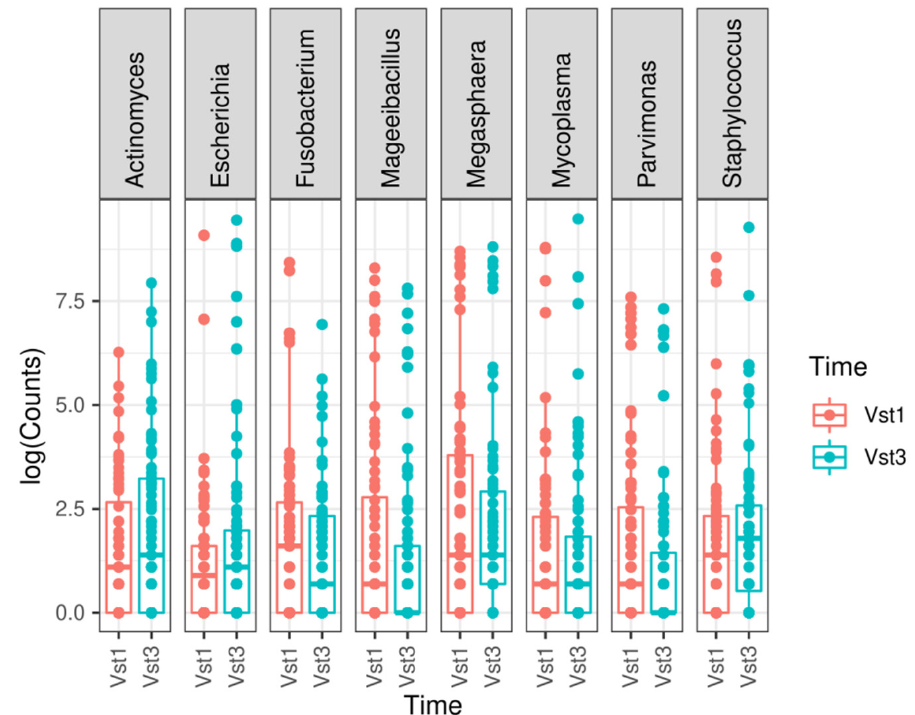
Figure 3. Most relevant genera found when comparing both visits. A boxplot is shown for each statistically significant genus. Vst1: baseline visit, red. Vst3: final visit, blue.